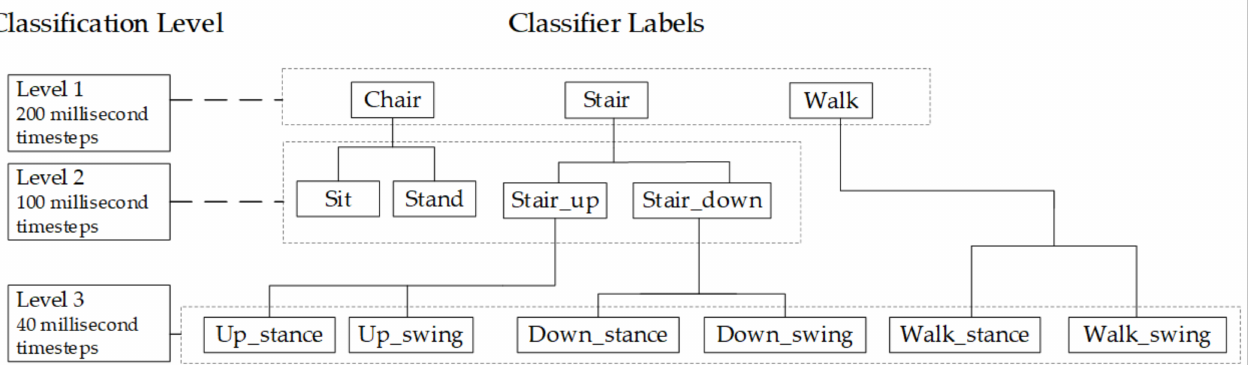
Figure 4. Decision tree for three levels of activity classification—Level 1 Activity, Level 2 Direction, Level 3